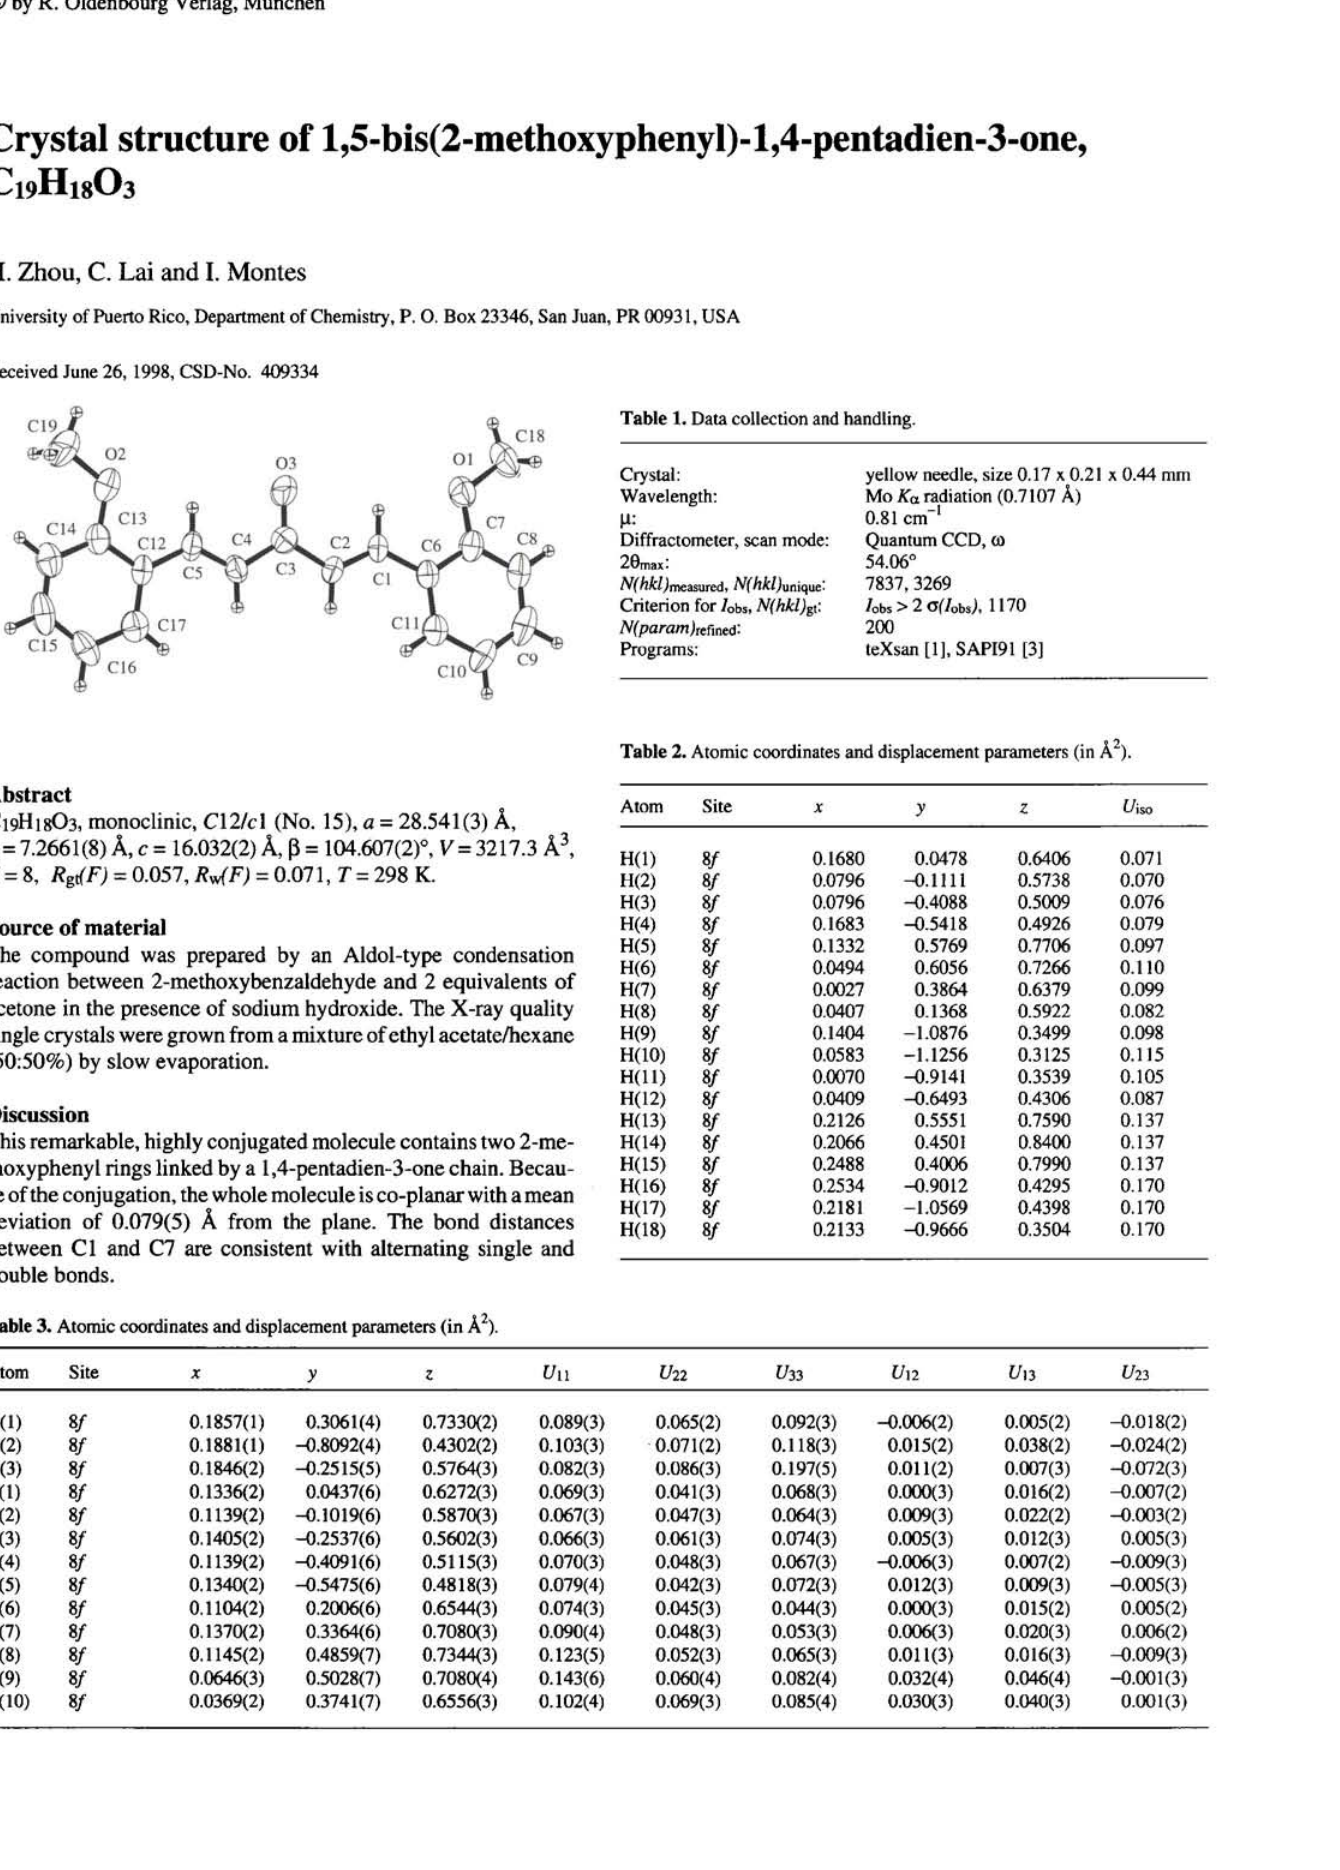
Table 1. Data collection and handling.